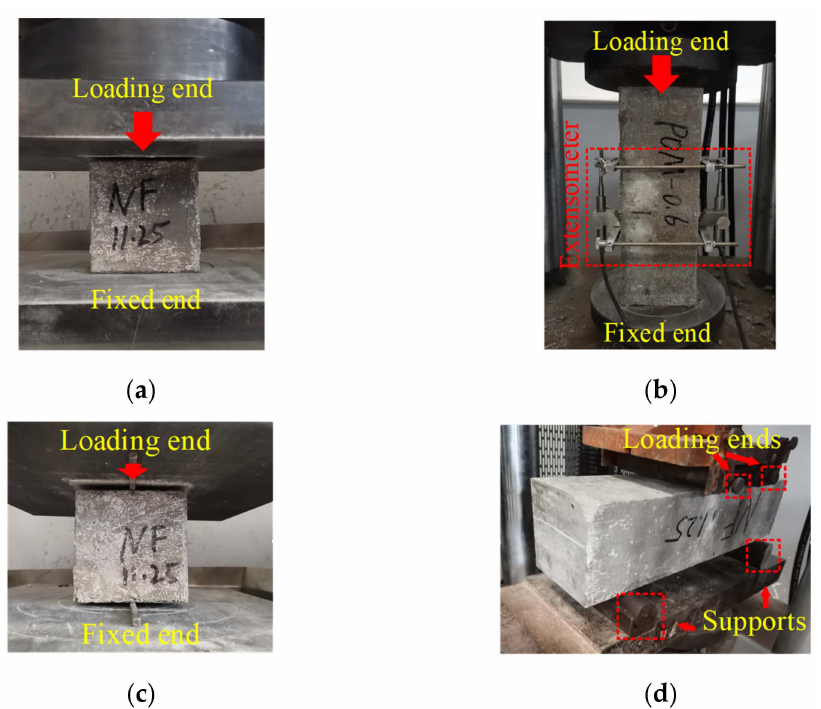
Figure 4. Different mechanical tests: ( a ) cube compression test; ( b ) axial compressive test; ( c ) splitting tensile test; and ( d ) flexural